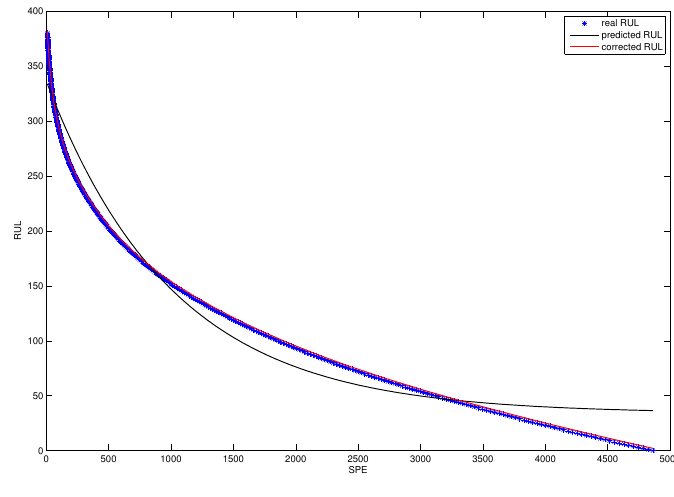
Figure 15. Online RUL prediction based on SPE. Figure 16 is the online RUL prediction based on the three designated components corresponding to D 3 , D 5 , and D 10 . The scatter chart denotes the real RUL, the black line is the rough predicted RUL, and the blue line is the corrected